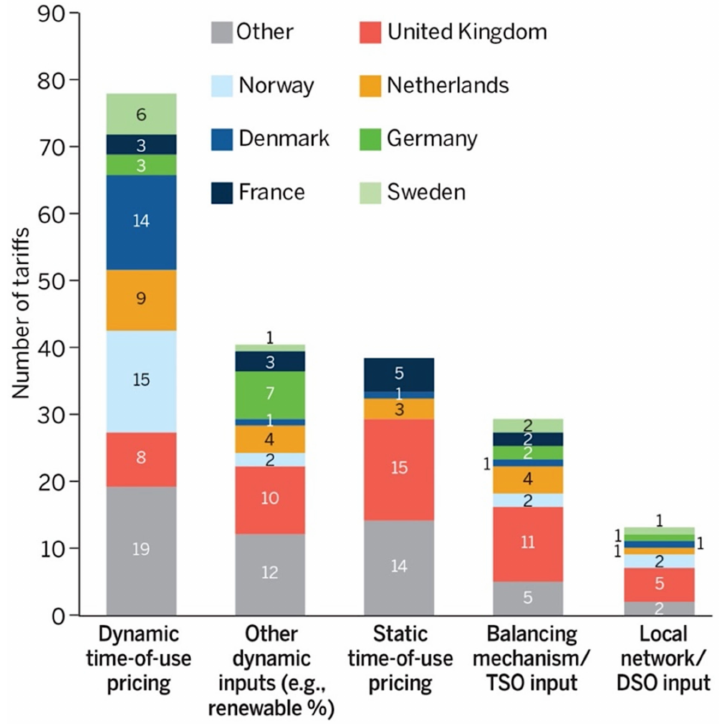
Figure 3. Input signals for smart tariffs and services for EV charging in